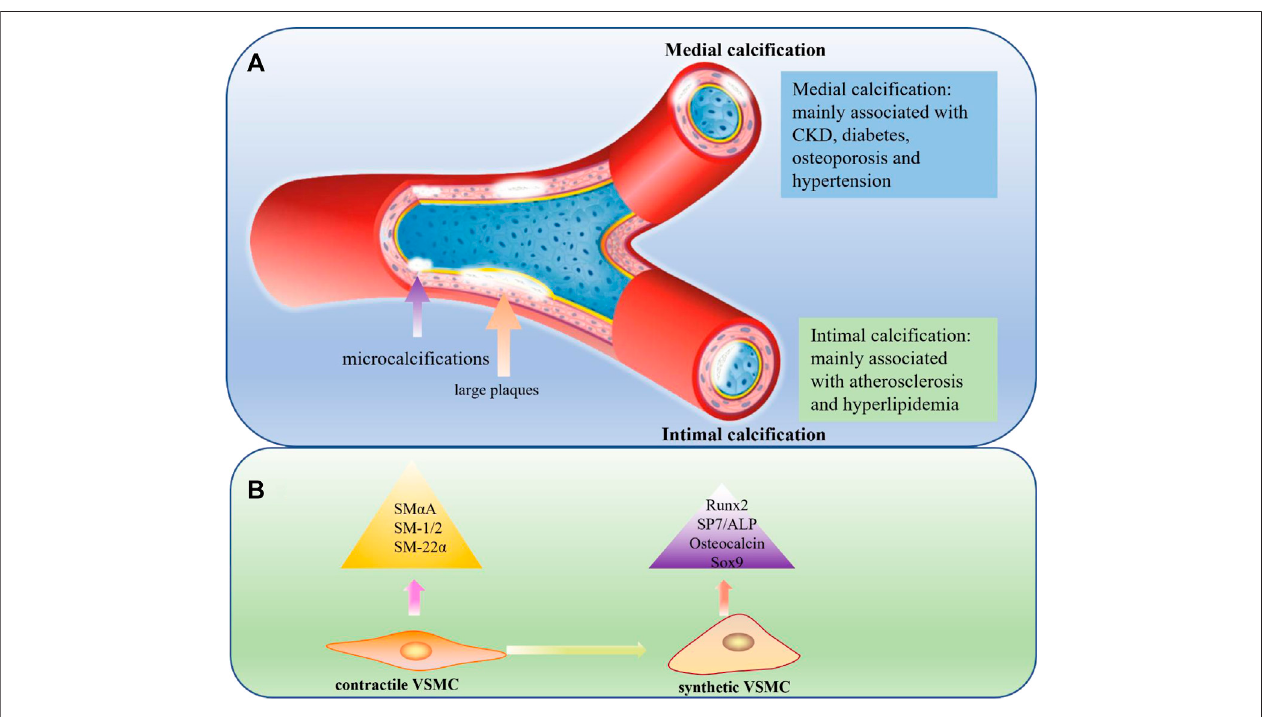
FIGURE 1 | (A) Medial calci fi cation and Intimal calci fi cation. In medial calci fi cation, minerals are mainly deposited in the medial layer of blood vessels and usually associated with CKD, diabetes, osteoporosis and hypertension. In intimal calci fi cation, minerals are primarily deposited in the intimal of the blood vessels and develop frommicrocalci fi cationstolargeplaques,usuallyassociatedwithatherosclerosisandhyperlipidemia.CKD:chronickidneydisease. (B) ComparisonofcontractileVSMC and synthetic VSMC. VSMCs paly an important role in medial calci fi cation and can undergo a phenotypic transition from a physical contractile phenotype to a pathological synthetic phenotype, lossing contractile markers like SM α -A, SM α -22, SM-1 and SM-2 and expressing mineralization-related markers like Runx2, SP7, ALP, osteopontin and